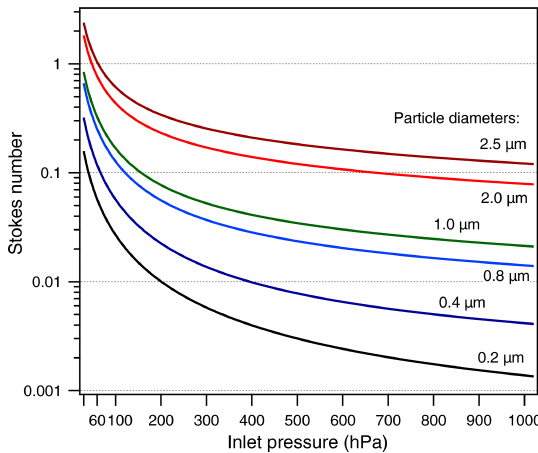
Figure 7. Stokes number calculated for different particle diameters as a function of inlet pressure in the range between 30 and 1020hPa, with CPI behavior of varying orifice diameter. A particle density of 1gcm − 3 is used (similar to that of polystyrene beads, which is 1.05gcm − 3 ). For other higher particle densities, the result can be upscaled